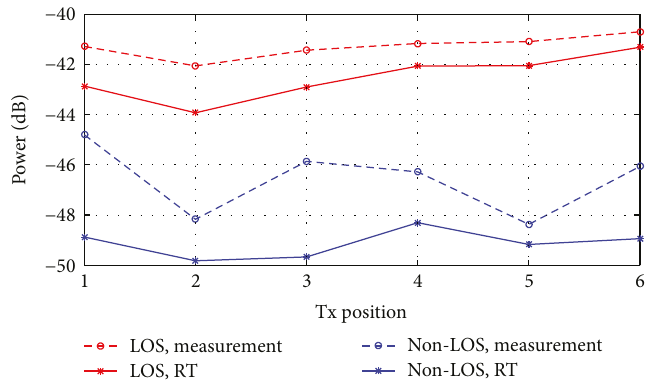
Figure 19: Measured and RT-simulated received power for all Tx positions for the LOS and obstructed LOS cases in the small o ffi ce scenario.